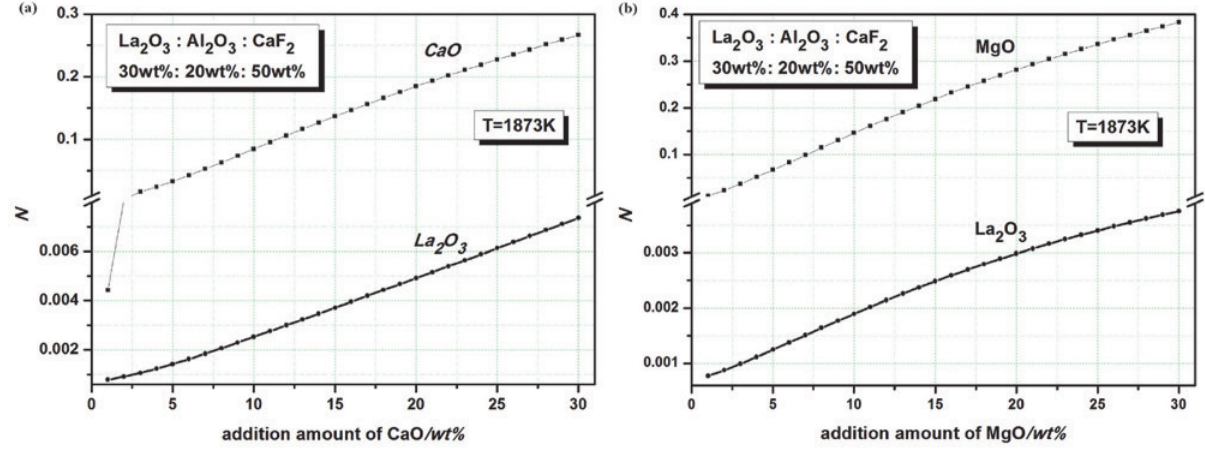
Fig. 4: The influence of CaO and MgO content on mass action concentration of La 2 O